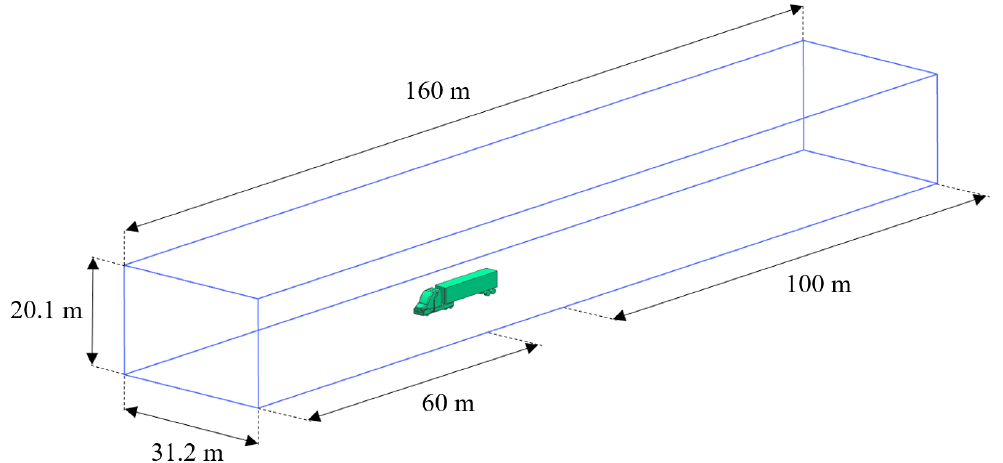
Fig. 2. CFD computational